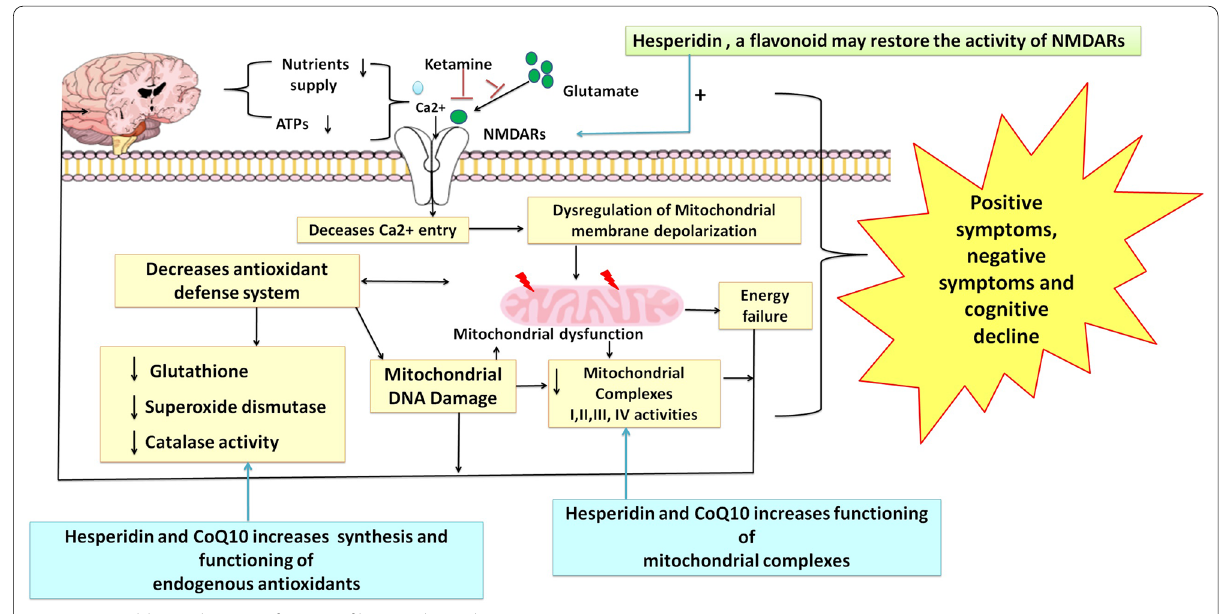
Fig. 19 Possible mechanism of action of hesperidin and